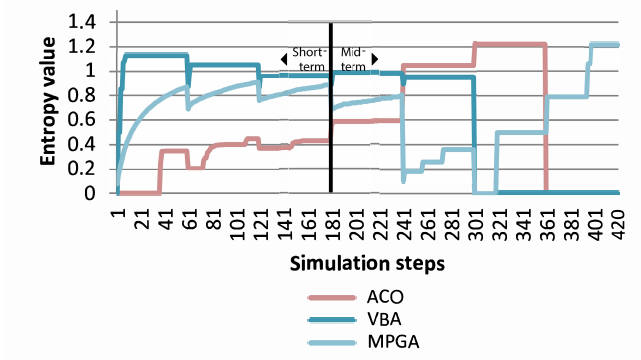
Figure 11. Algorithm comparison under severe (82%)